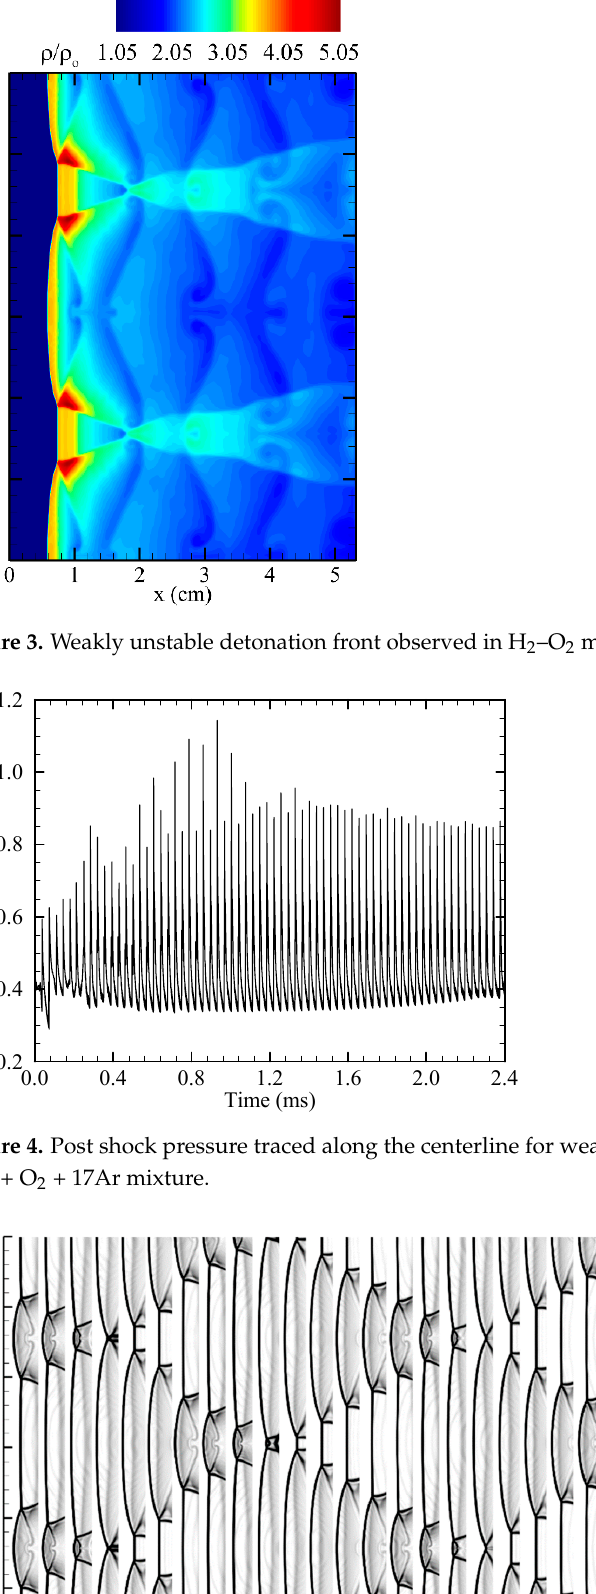
Figure 6. Smoked foil record for weakly unstable detonation case with 2H 2 + O 2 + 17Ar mixture. 3. Modal Decomposition The dynamic mode decomposition (DMD) is a data processing algorithm that ex- tracts coherent structures with a single temporal frequency from a numerical or experi-